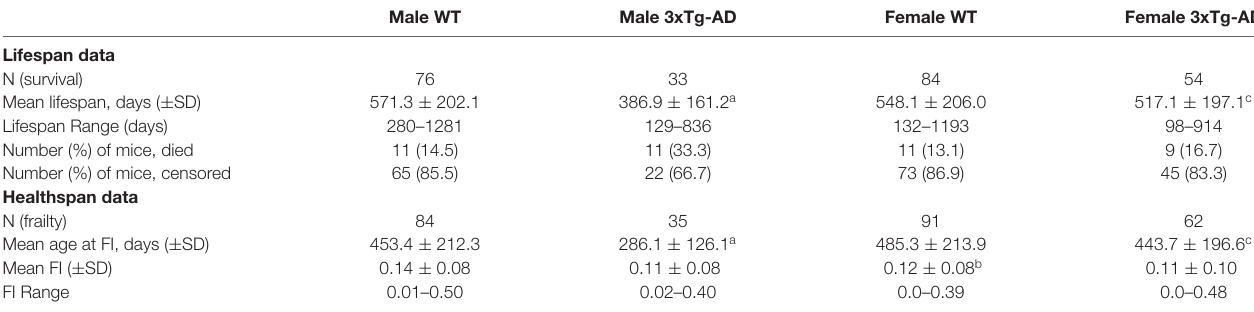
TABLE 1 | Summary data for lifespan and healthspan measures for each mouse group. Male WT Male 3xTg-AD Female WT